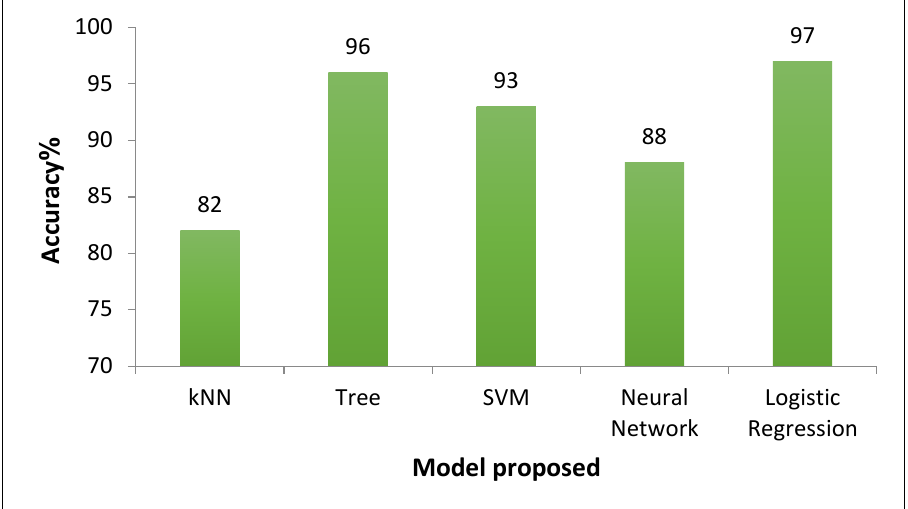
Figure 6. The prediction values of the different algorithms.